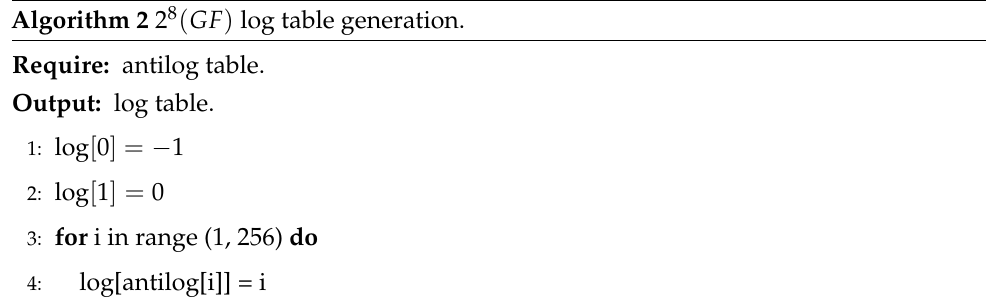
Algorithm 2 2 8 ( GF ) log table